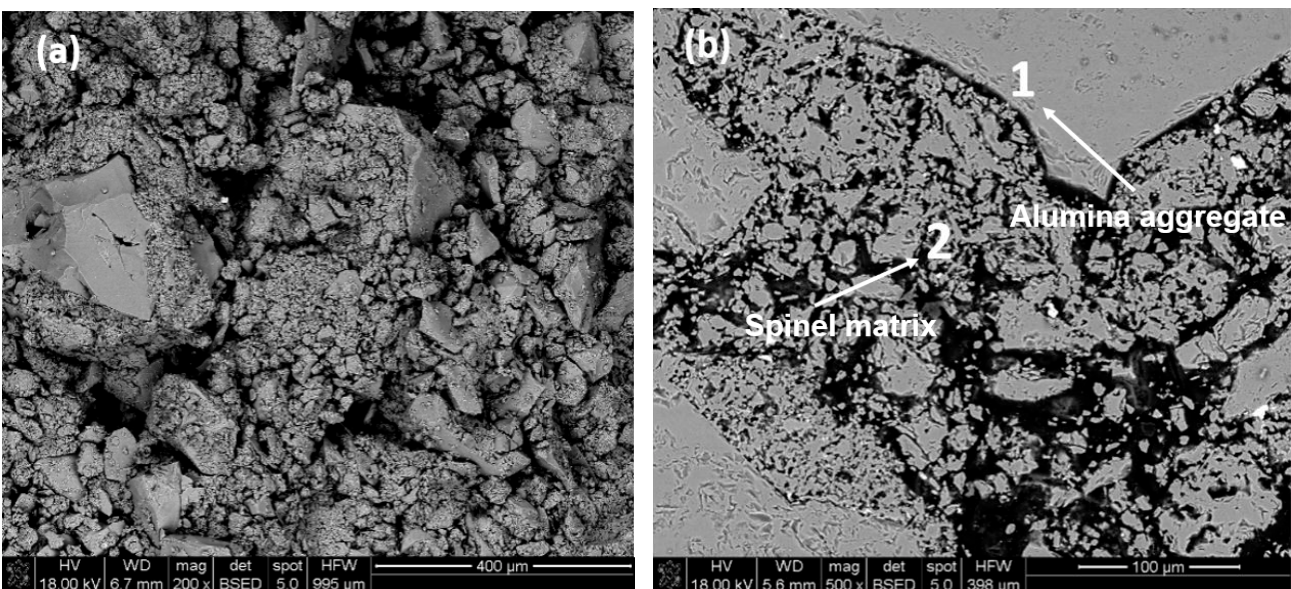
Figure 8. SEM micrographs with EDS analysis in selected areas of alumina-spinel brick: ( a ) fracture surface, ( b ) polished cross-section (point 1: alumina, and point 2: spinel). Table 5. EDS analysis of micro-areas indicated in Figure 8.